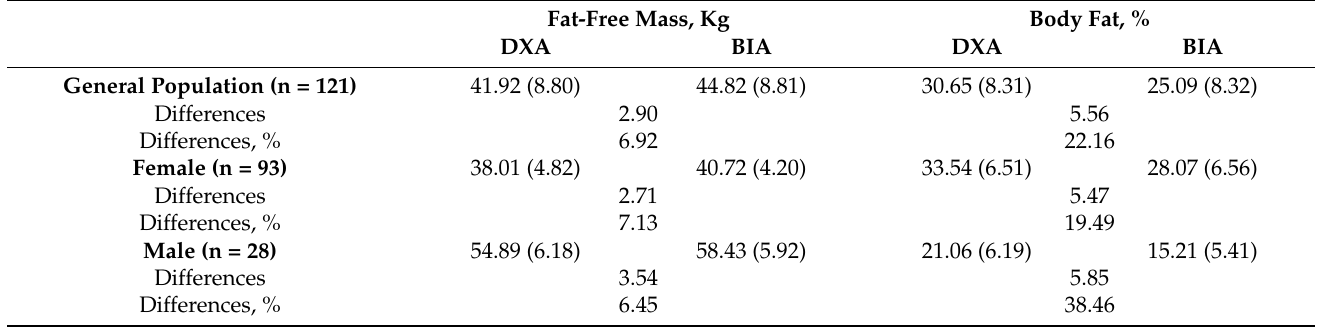
Table 2. Differences in fat-free mass and fat mass between the two methods studied (BIA and DXA). Fat-Free Mass, Kg